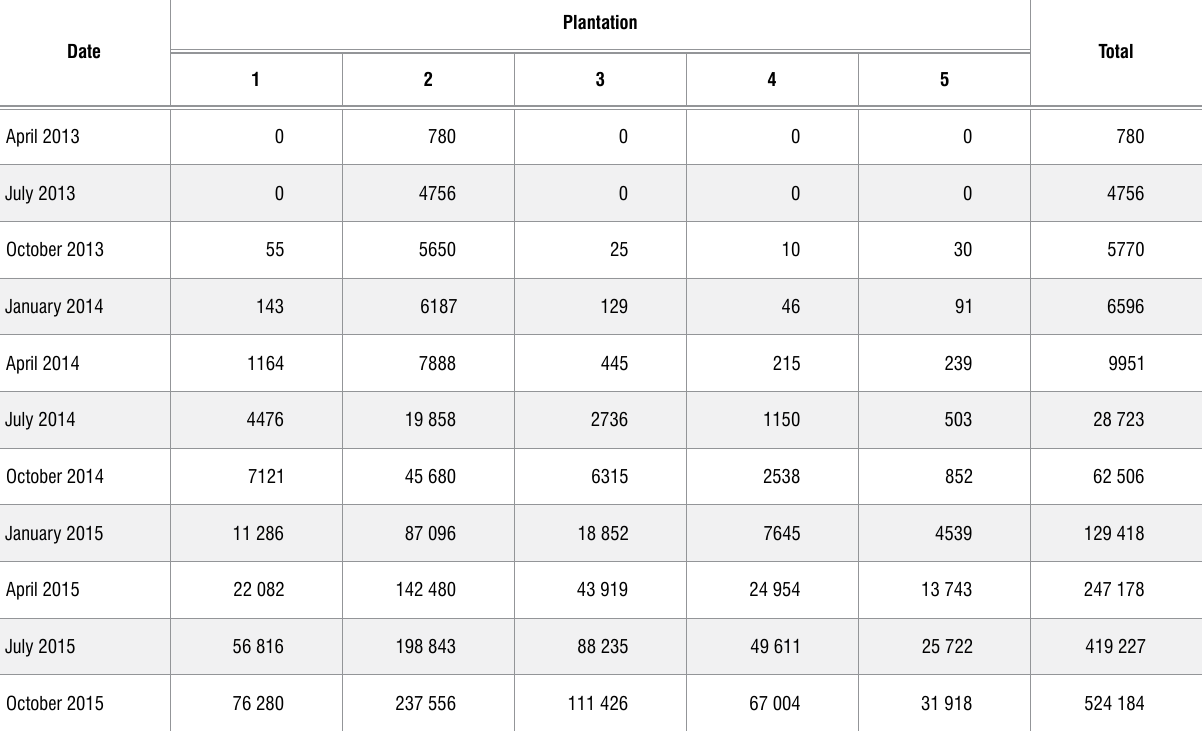
The number of plants affected by banana Fusarium wilt TR4 at Metocheria farm between August 2013 and July